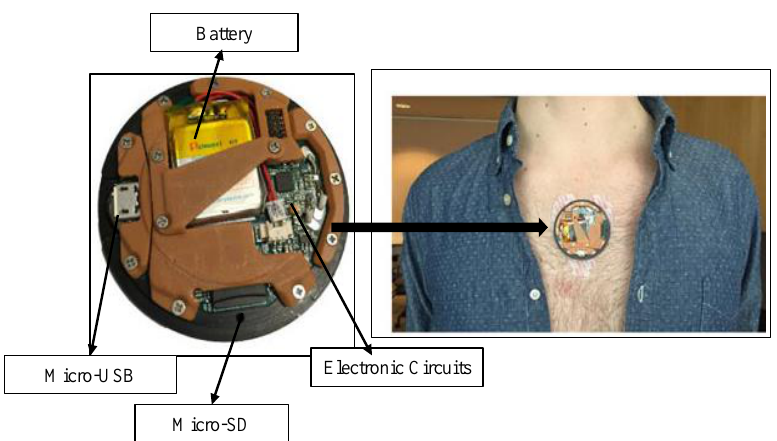
Figure 6. A wearable device for the collection of ECG/SCG signals and its